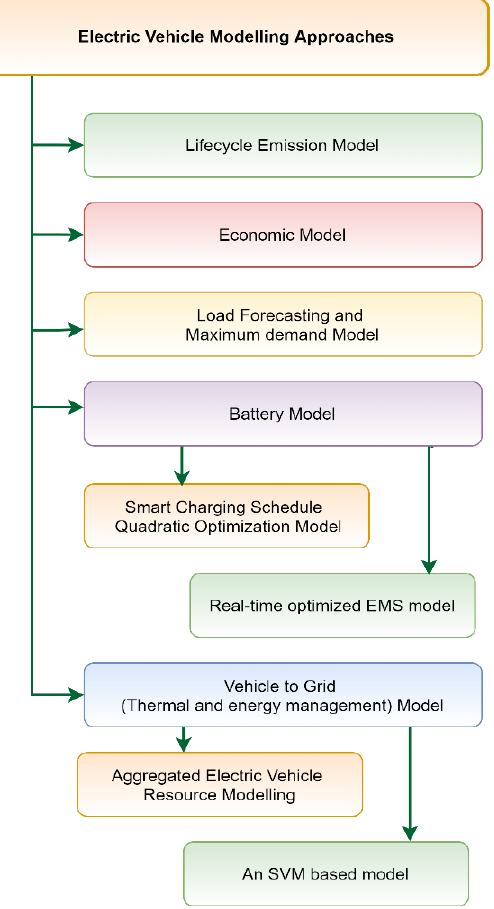
Figure 8. Classification of the various modelling approaches based on certain critical parameters .